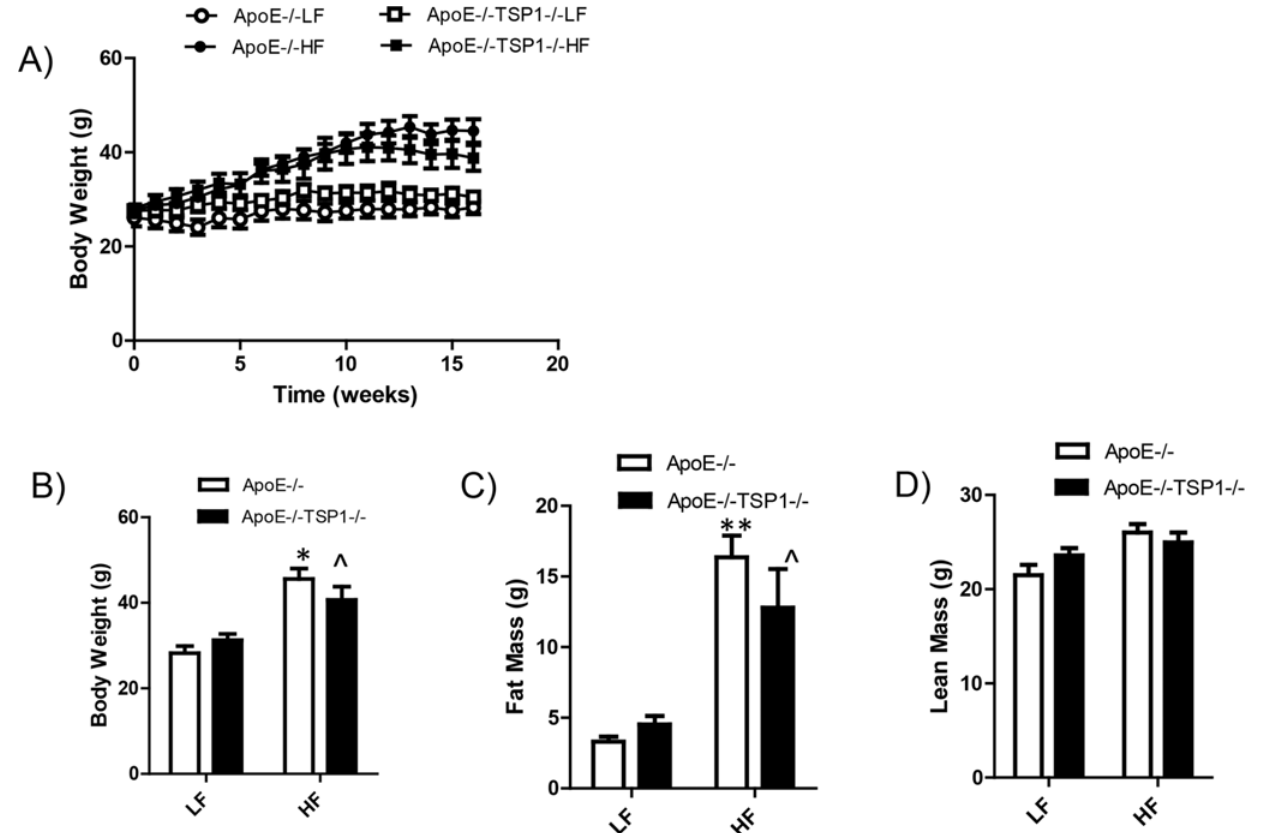
Fig 1. TSP1 deficiency had no effect on diet induced obesity in ApoE-/-mice. Male ApoE-/- mice and ApoE-/-TSP1-/- mice were fed LF or HF diet for 16 weeks. A ): Graphs showing the increase of body weight over time on diets. B ): body weight of mice at the end of the study. C ) and D ): Fat and lean mass of different groups of animals. Data are represented as mean ± SE (n = 10 mice/group). * p < 0.05 or ** P < 0.01vs. LF ApoE-/-; ^P < 0.05 vs. LF TSP1-/-ApoE-/-